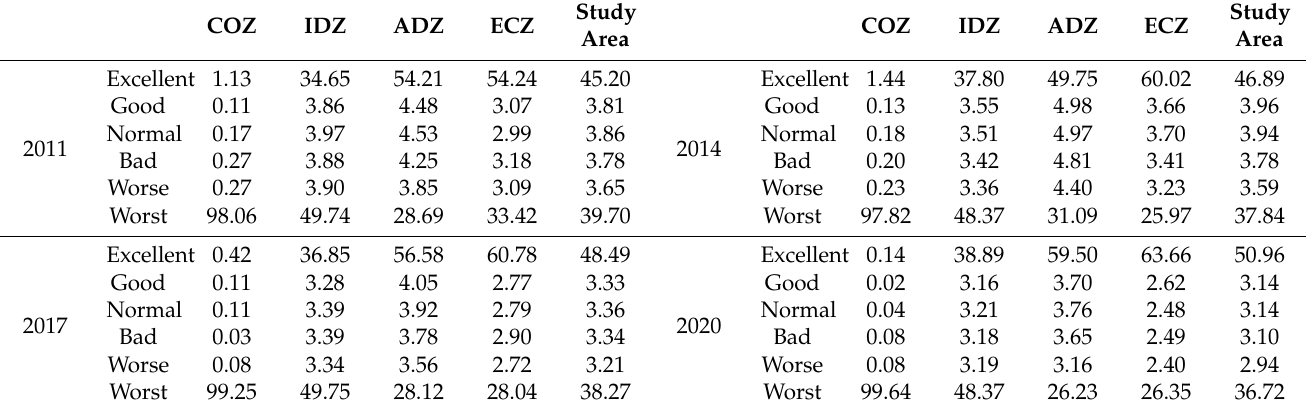
Table 4. The area percentage of UTFVI of each MFOZ from 2011 to